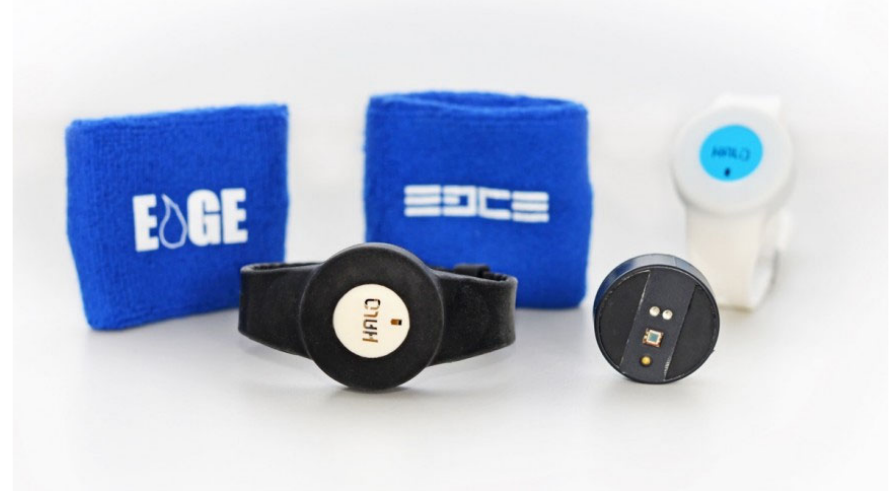
Figure 9. Halo Edge wearable hydration monitor, Halo Wearables [61].